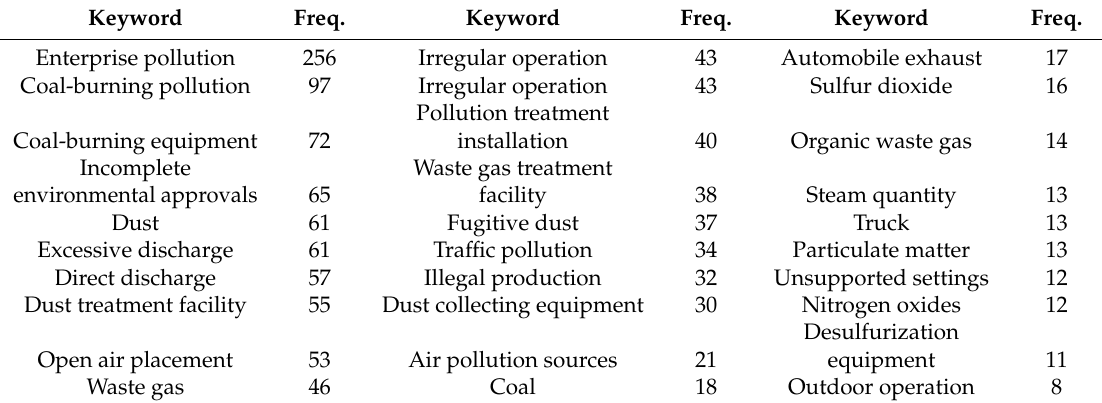
Table 1. Categories of high-frequency keywords (found more than 8